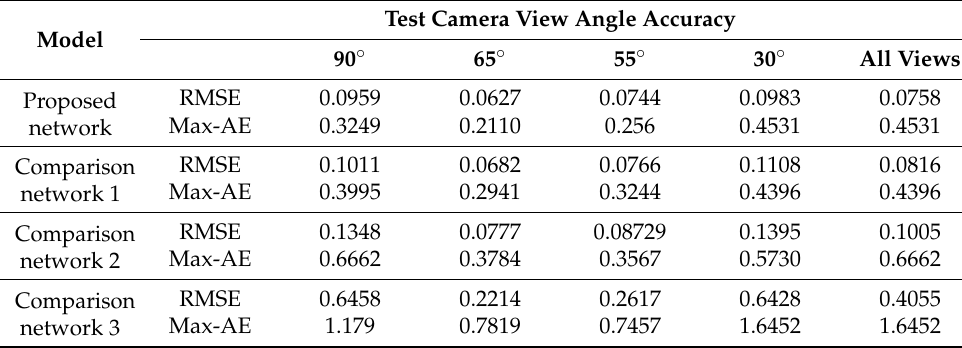
Table 2. Comparison of estimation method results in untrained